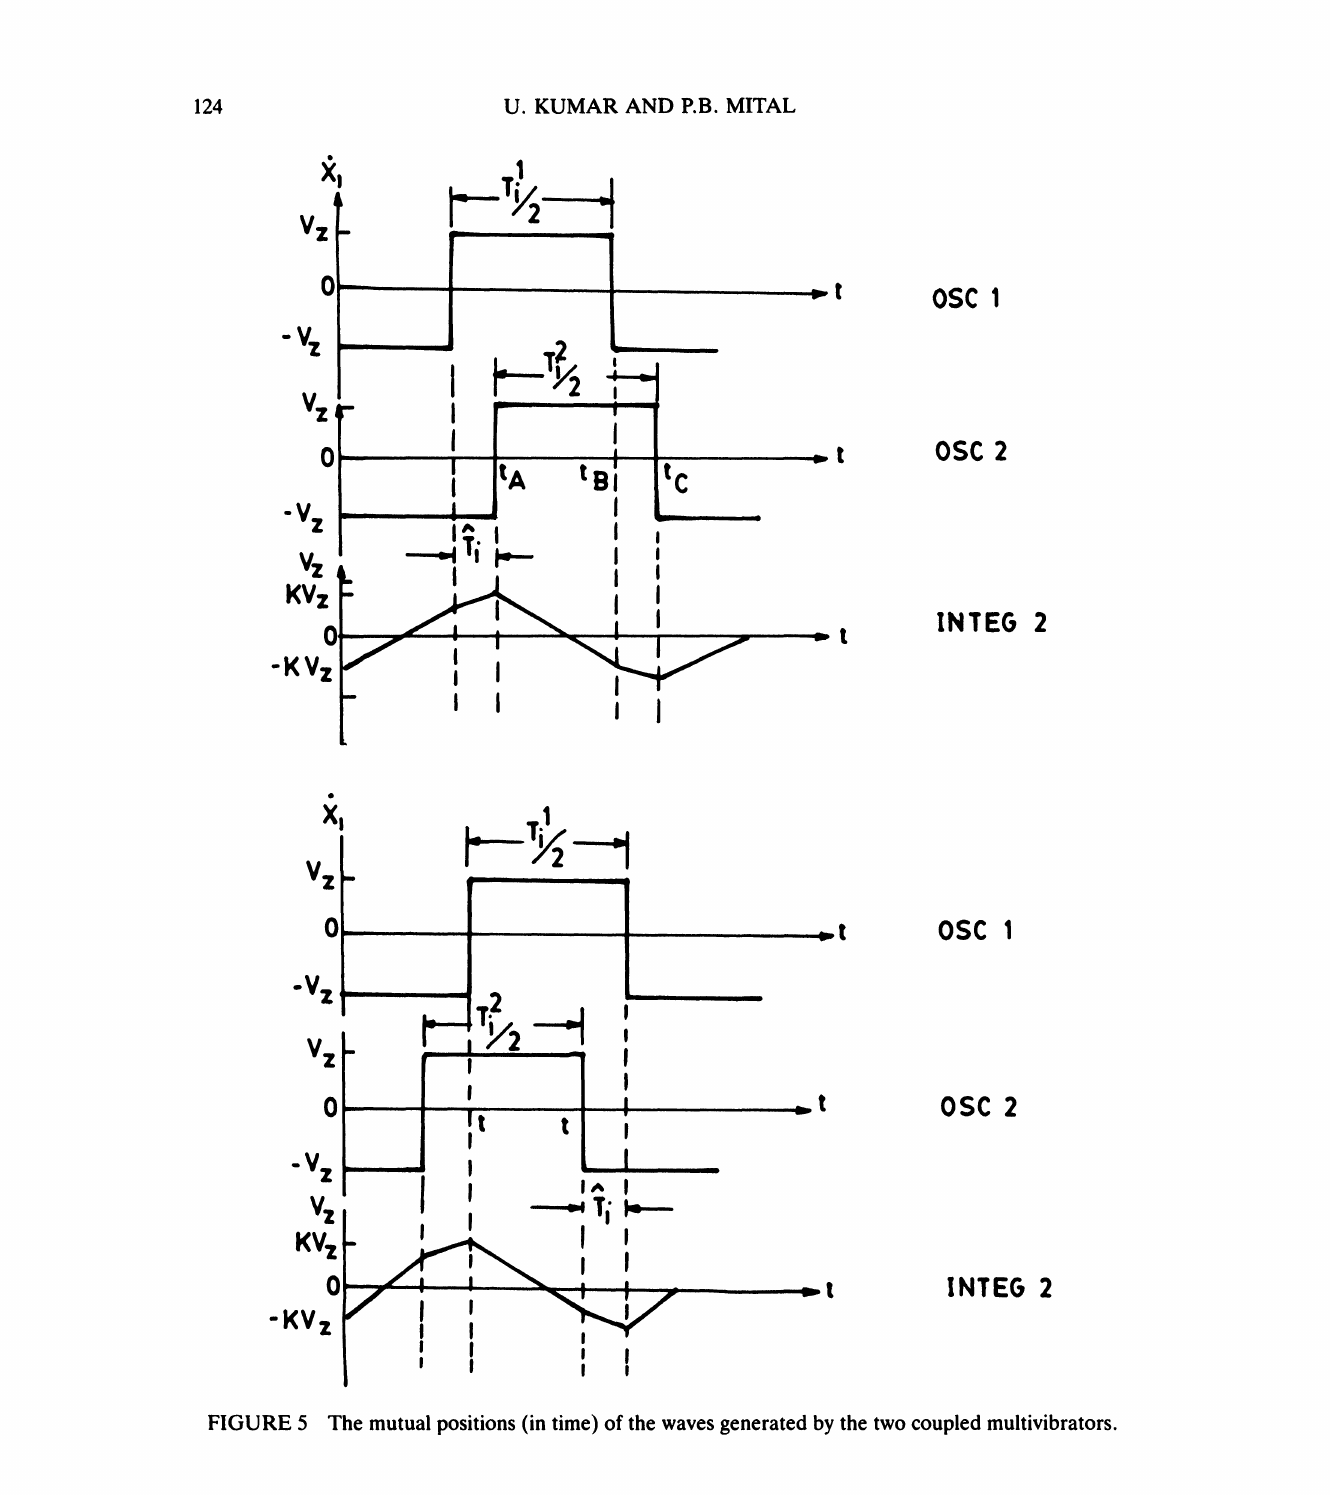
FIGURE 5 The mutual positions (in time) of the waves generated by the two coupled